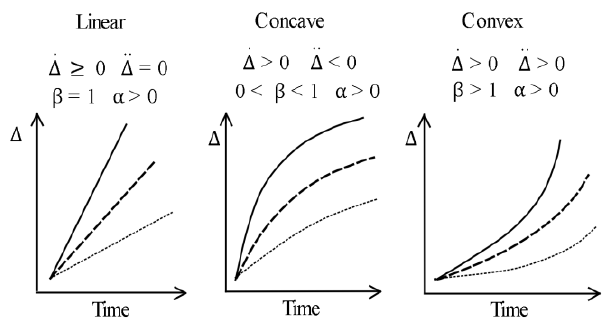
Figure 1. Possible forms for degradation models adapted from Medjaher and Zerhouni (2009)